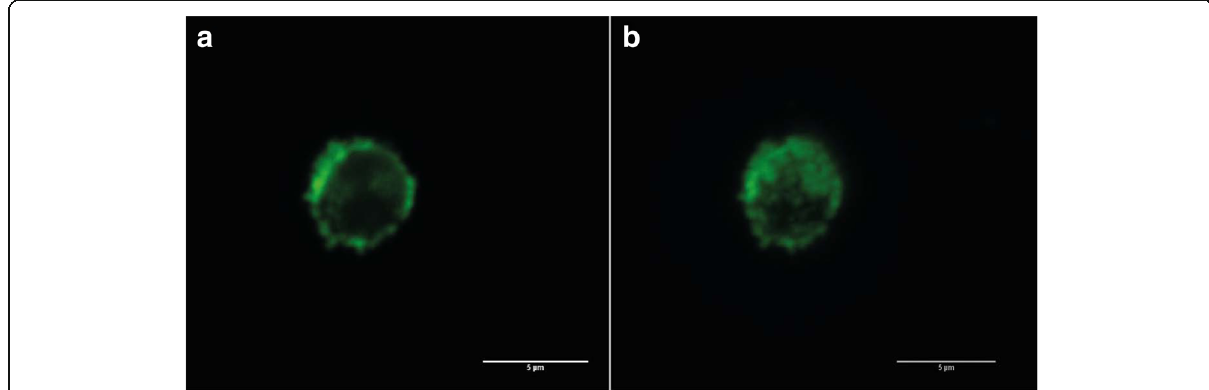
Fig. 6 Confocal microscopy images of the polyelectrolyte microcapsules encoded with quantum dots and coated by BSA: cross-sections of the microcapsules ( a ); 3D projection of a single polyelectrolyte microcapsule ( b